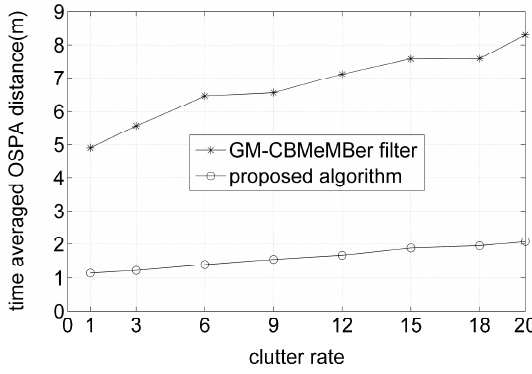
Figure 7. Time-averaged OSPA distances for different algorithms versus clutter rate.